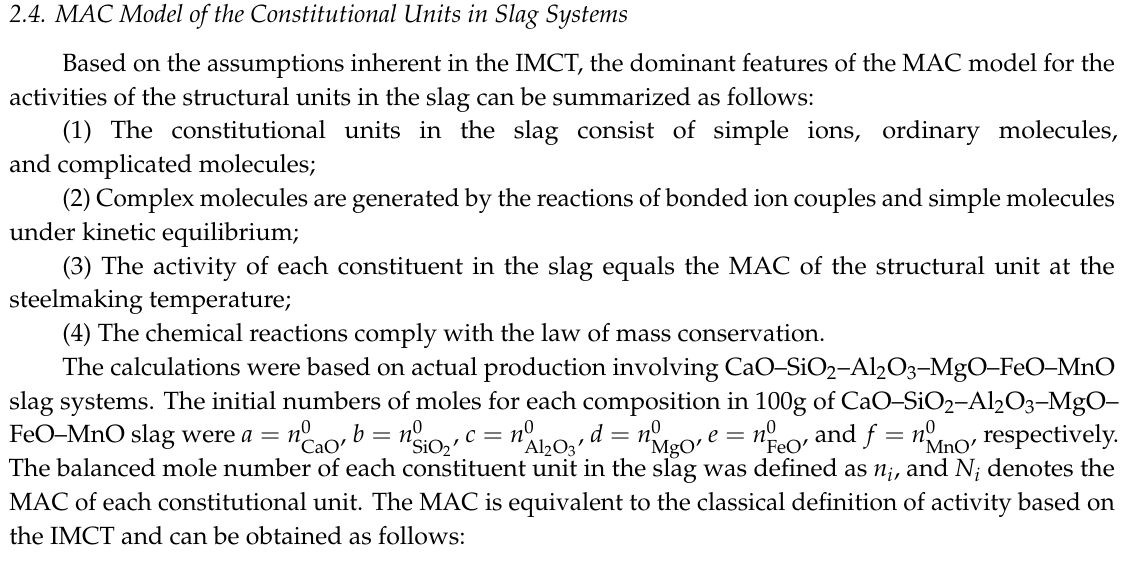
Figure 6. Diagram showing the four potential sources of Mg in liquid